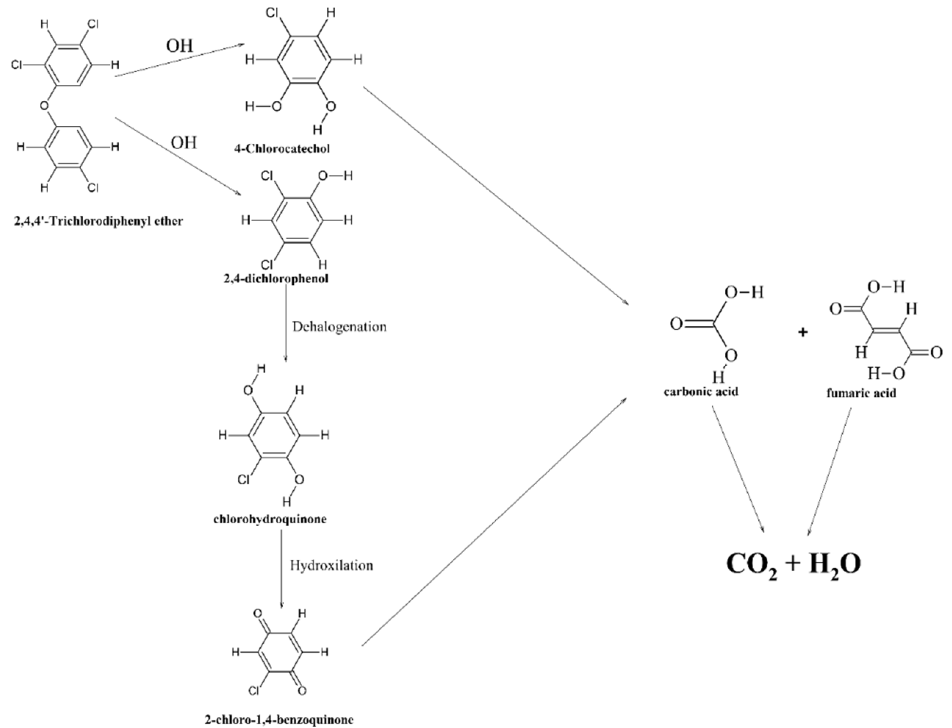
Figure 5. The proposed pathways of the degradation of TCS in a hetero-electro-Fenton process with the Mn/Fe@PC-CP cathode according to [53].